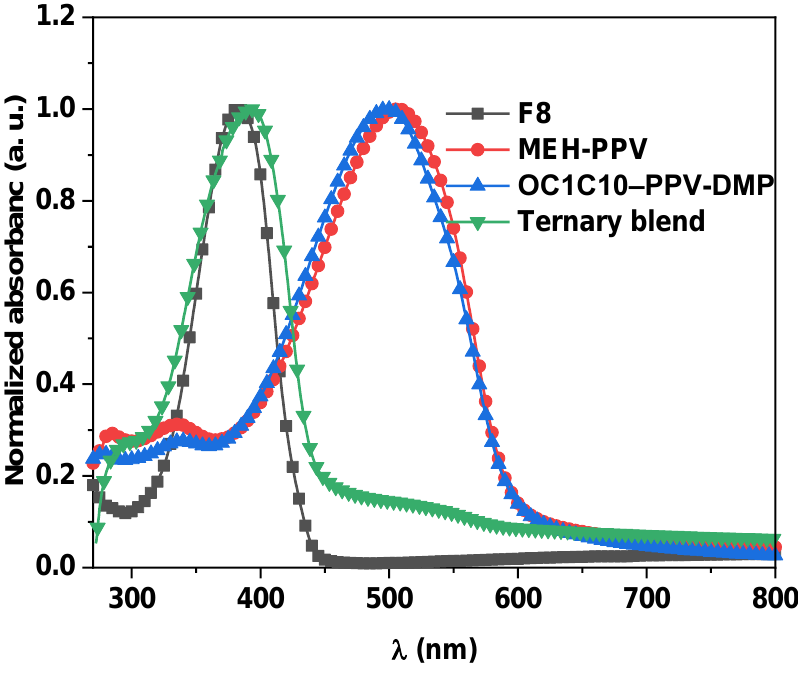
Figure 3. Normalized absorbance spectra of pristine F8, MEH-PPV, OC1C10–PPV-DMP and their ternary hybrid .